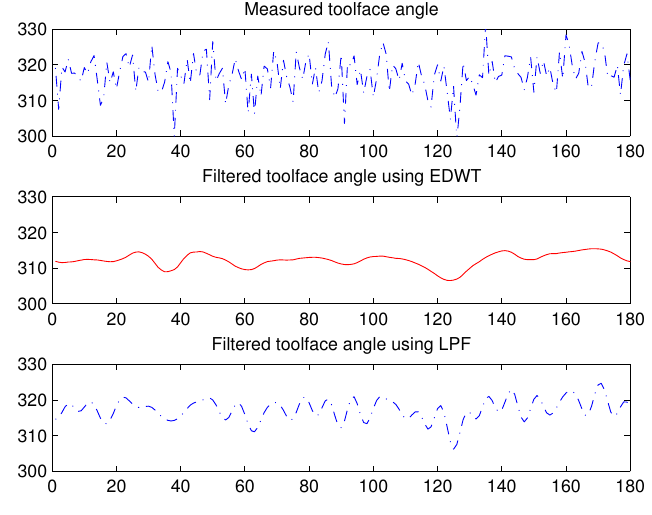
Figure 11. Comparison of tool-face angle before and after filtering. The actual data collected by the accelerator from a real well have been